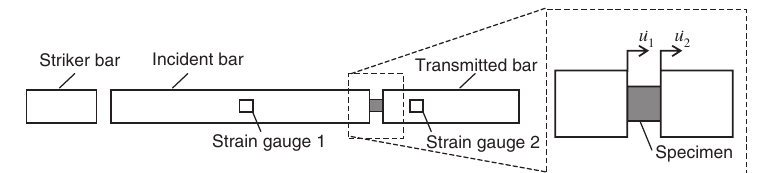
Figure 3 A schematic of typical split Hopkinson pressure bar configuration in compression showing bar arrangement, specimen location, and strain gauge setup with an illustration of the bar velocities,